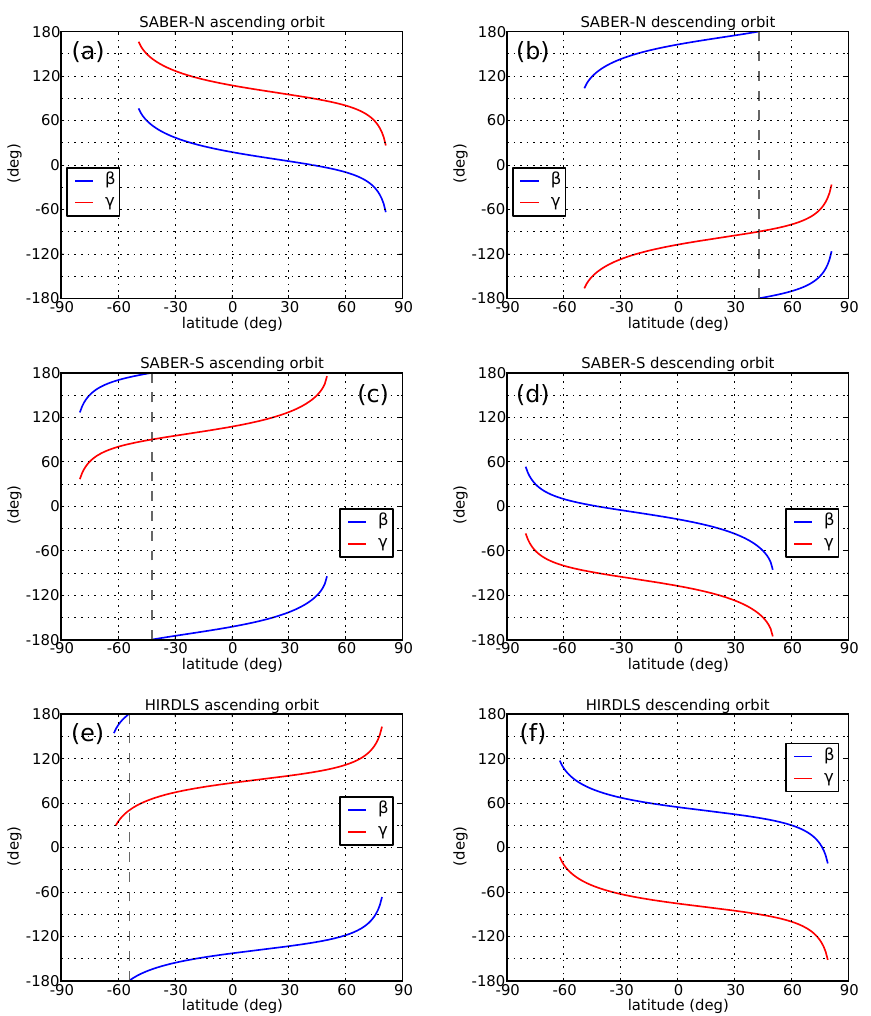
Figure C1. Dependences of β and γ on latitude for different orbit directions of (a–d) SABER and (e, f) HIRDLS. For details, see